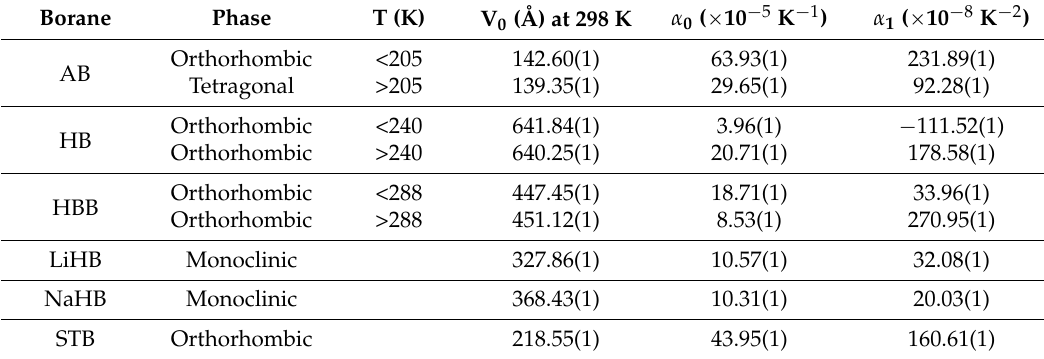
Table 2. Parameters ( V 0 , α 0 and α 1 ) of the thermal equations of state obtained for the boranes, with T (K) as the temperature of transition.